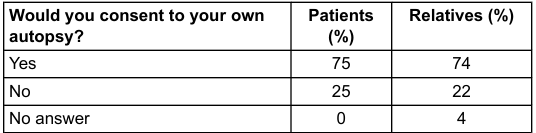
Table 4: Consent to own autopsy (questionnaire 1).